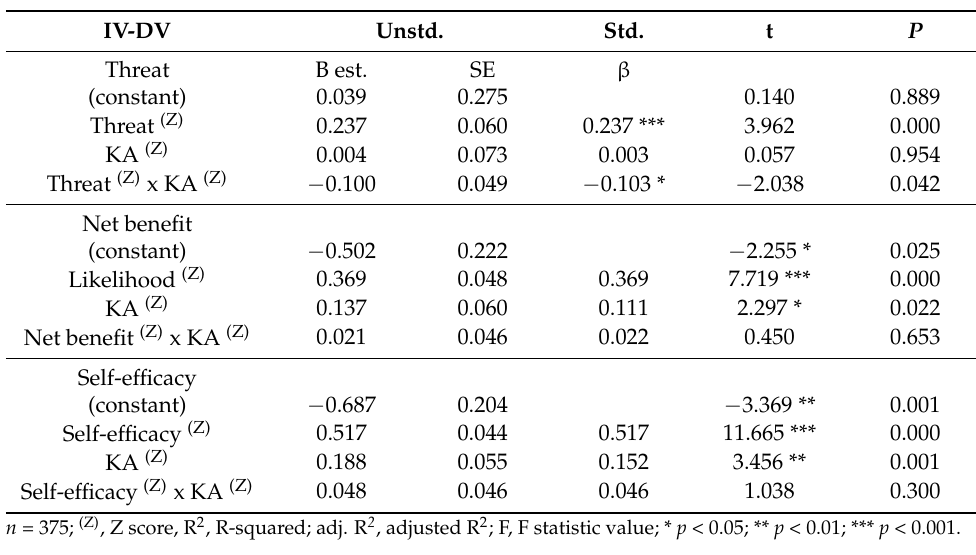
Table 6. Moderating effects of knowledge and attitude.